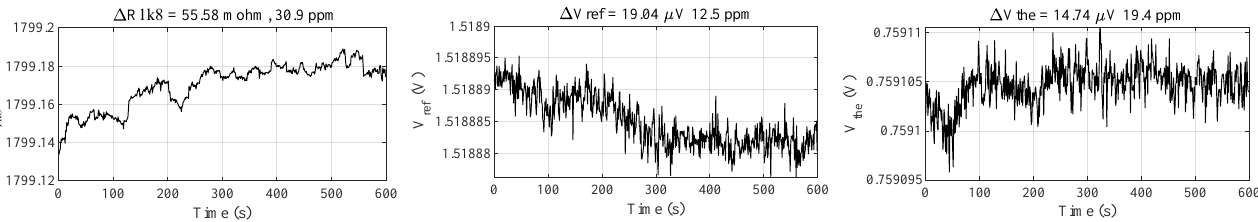
Figure 6. Drift of the value of low-temperature drift resistance, drift of the voltage of external reference REF5025, and drift of the voltage applied to the thermistor of the